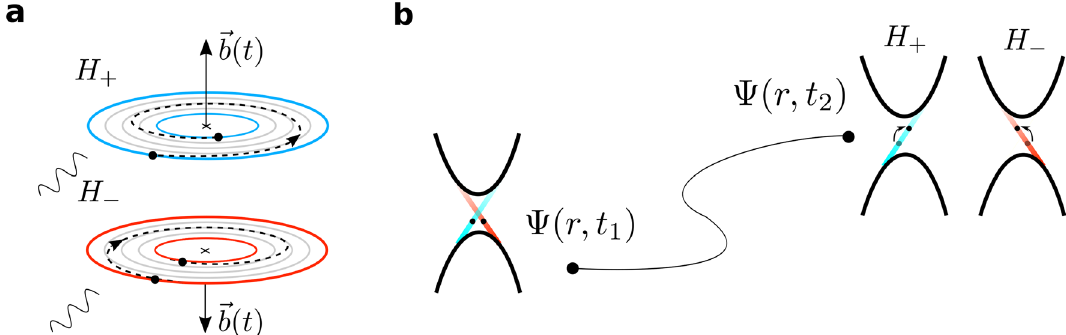
Figure 4. Adiabatic coherent process with ∂ C /∂ T = 0 ( a ) Illustration of an adiabatic coherent process, for which the magnitude of the field b increases. Blue and red circles represent the initial and resulting final states on each branch defined in H 2 D . ( b ) Adiabatic coherent evolution of electronic wavefuntion �( r , t ) . Seebeck coefficient and entropy are not modified in this process allowing heat-electricity transformation in a completely reversible process. As a consequence of the enlargement of the b field and the Berry curvature, the moment of the possible final states p 2 are higher than the initial electron moment p 1 . Below the critical value, edge states remain to be ballistic with their conductance